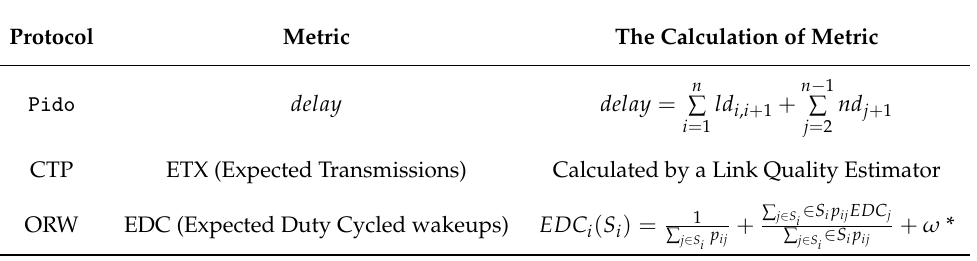
Table 2. The comparison between Pido , CTP and